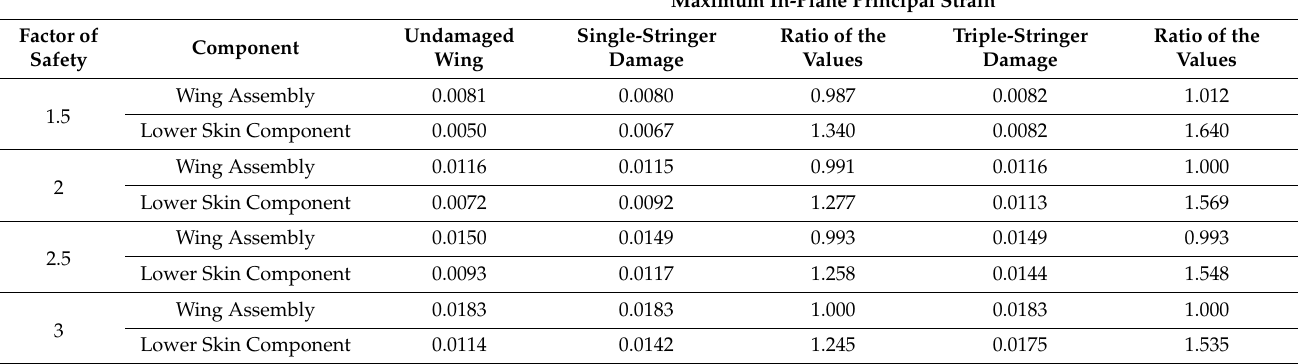
Table 11. Comparison of maximum in-plane principal strain in the undamaged wing and wing containing stringer